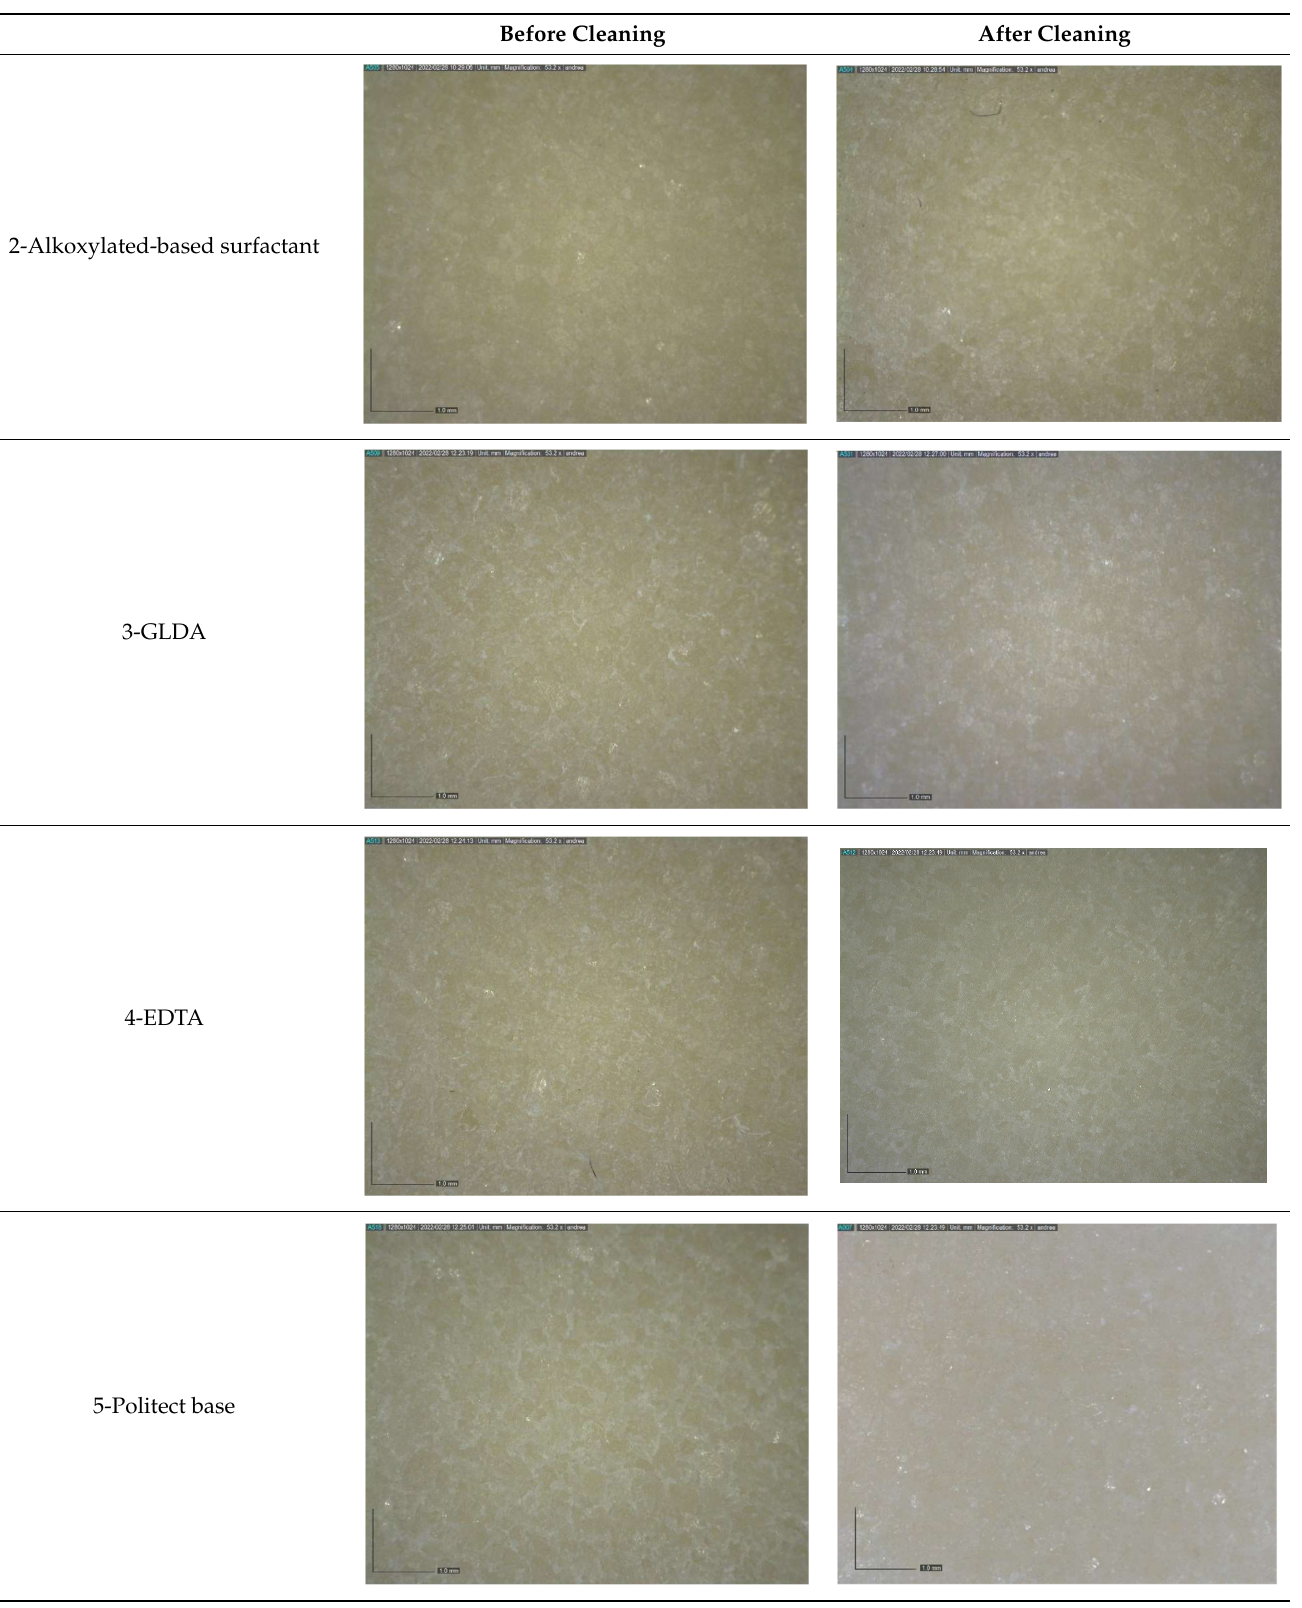
11 Figure 8. Photographs of the surfaces after treatment. The comparison between the images acquired using DinoLite ® before and after the cleaning tests confirm that GLDA and Politect ® Base show the greatest cleaning power (Table 6). All the images collected show that the original morphology of the marble sur- face has been preserved. Table 6. Dinolite ® images of the areas before and after treatment. Before Cleaning After Cleaning